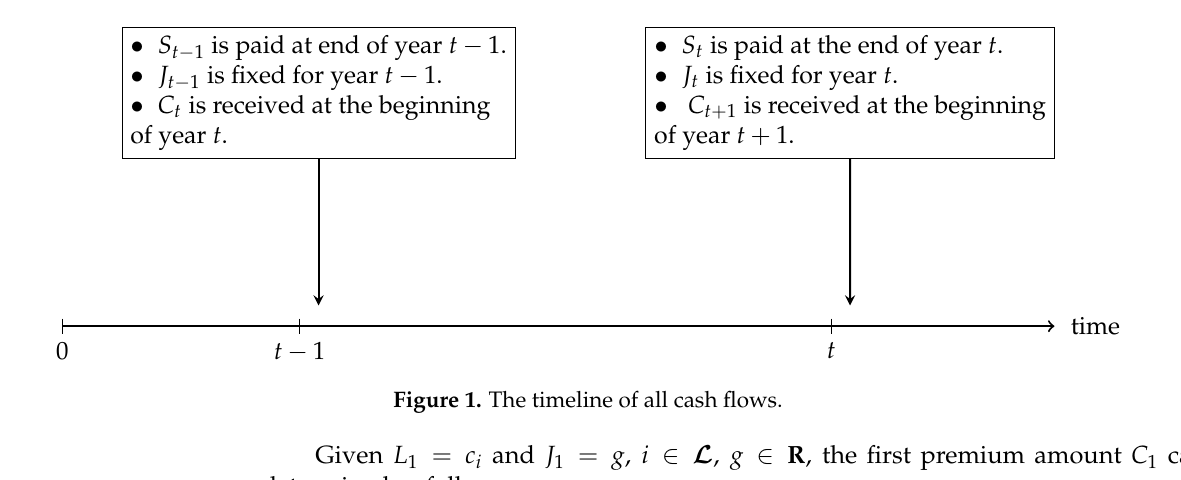
Figure 1. The timeline of all cash